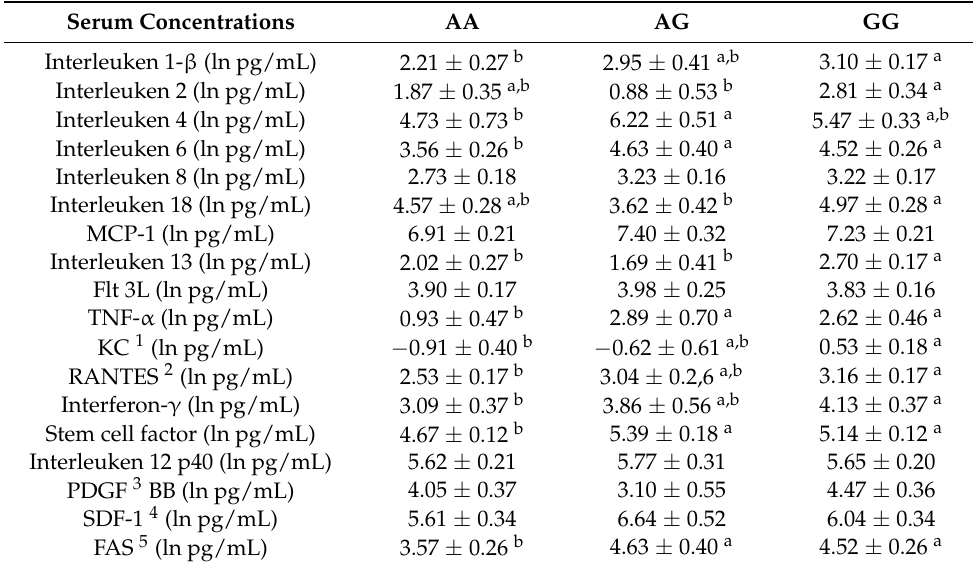
Table 5. Concentrations (natural log of means ± SEM) of selected serum cytokines in cats with different alanine-glyoxylate aminotransferase 2 (AGXT2) single nucleotide polymorphisms (SNPs), averaged across time (there was no effect of food and no interaction of food and time).